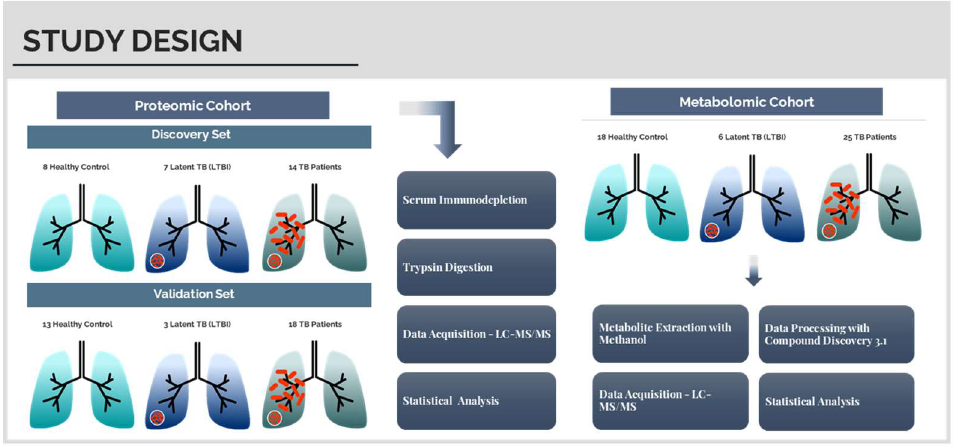
Figure 1. Figure 1. Design of the study, including a proteomic and a metabolomic cohort and the experimental workflow.